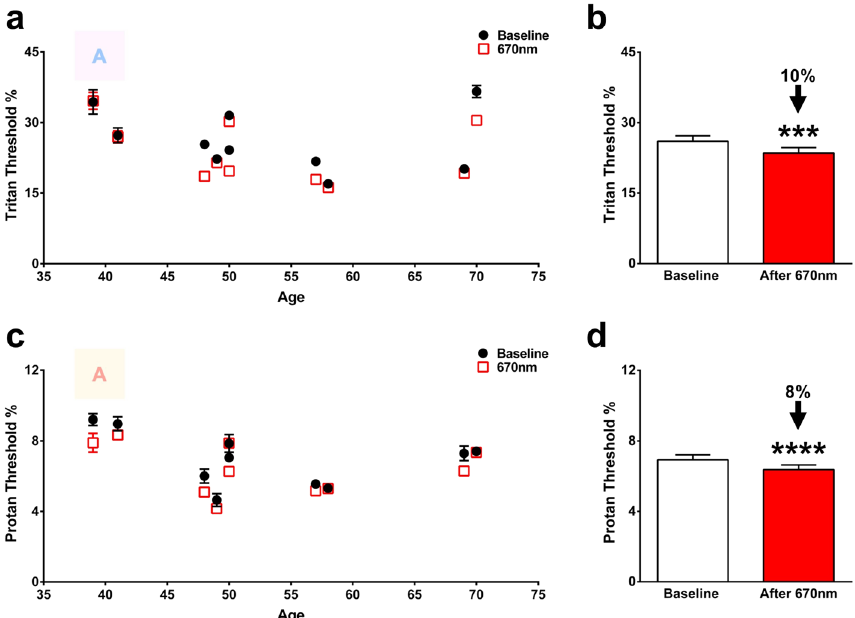
Figure 5. Colour contrast sensitivities measured 1 week later from a morning exposure of 670 nm. CCS of tritan ( a ) and protan ( c ) axes from 10 healthy subjects with their response to a single dose of 670 nm measured 1 week later, without any further 670 nm exposure in the intermediary period Black closed circles represent baseline measurements and red open boxes are those in the same individuals measured 1 week later from a single 3 min 670 nm light exposure delivered in the morning. Some subjects displayed a return of their thresholds to baseline, whereas some still had a reduction. The colour letter A in both graphs is an example of the target to be identified as it appeared on the screen. ( b ) Thresholds for tritan function in individuals 39–70 years. There was a 10% sustained reduction to tritan thresholds (p = 0.0001) across the population from baseline measures. ( d ) Thresholds for protan function in individuals 39–70 years. There was an 8% sustained reduction to protan thresholds (p < 0.0001) across the population from baseline measures a week following 670 nm exposure. Wilcoxon matched-pairs signed rank test was used for statistical analysis. Data are presented as means ± SEM. ***p ≤ 0.0001, ****p <